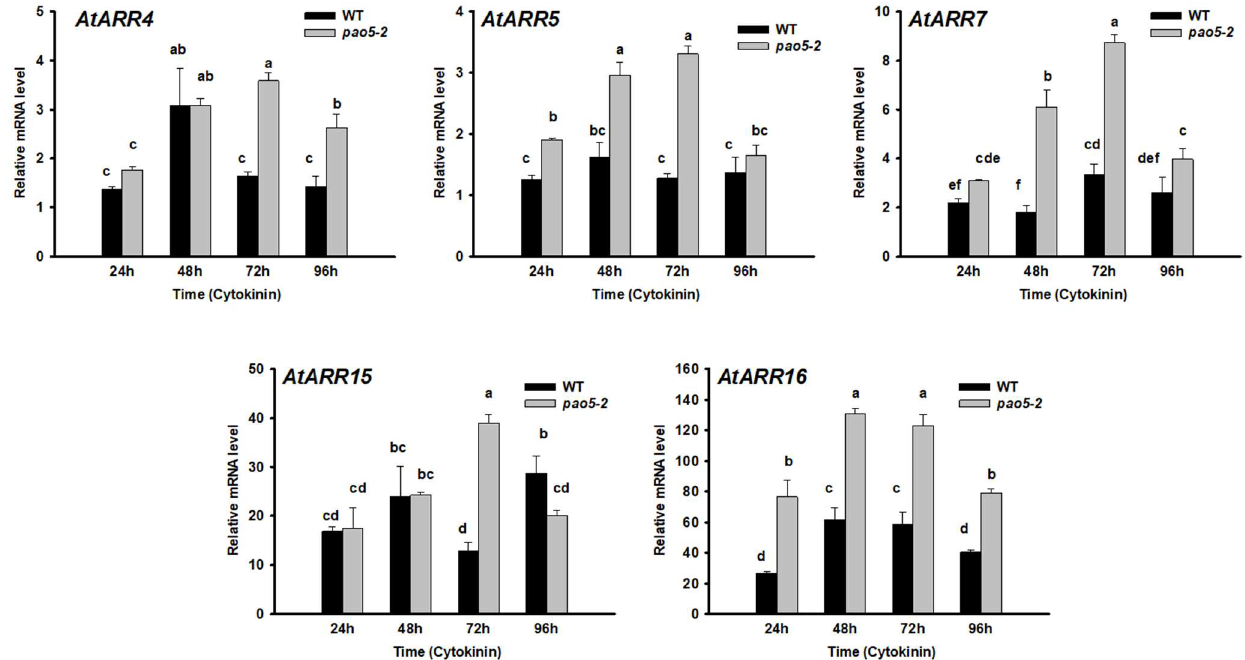
Figure 4. Relative mRNA levels of genes coding for type-A Arabidopsis response regulators (AtARRs) during shoot organogenesis in wild type (WT) and pao5-2 mutants after 24, 48, 72, and 96 h cytokinin induction. The mRNA levels of the UBIQUITIN 1 (At3G52590) and PP2A3 (At1G13320.1) genes were used for gene expression normalization. The mRNA level of the untreated root tissue was used as reference (relative mRNA level: 1). Data were averaged from three independent biological experiments with three technical replicates each. Standard errors are shown on the columns. The significance of difference between sets of data was determined by one-way analysis of variance (ANOVA) following Duncan’s multiple range tests; a p -value of less than 0.05 was considered significant. Different letters indicate significant differences.